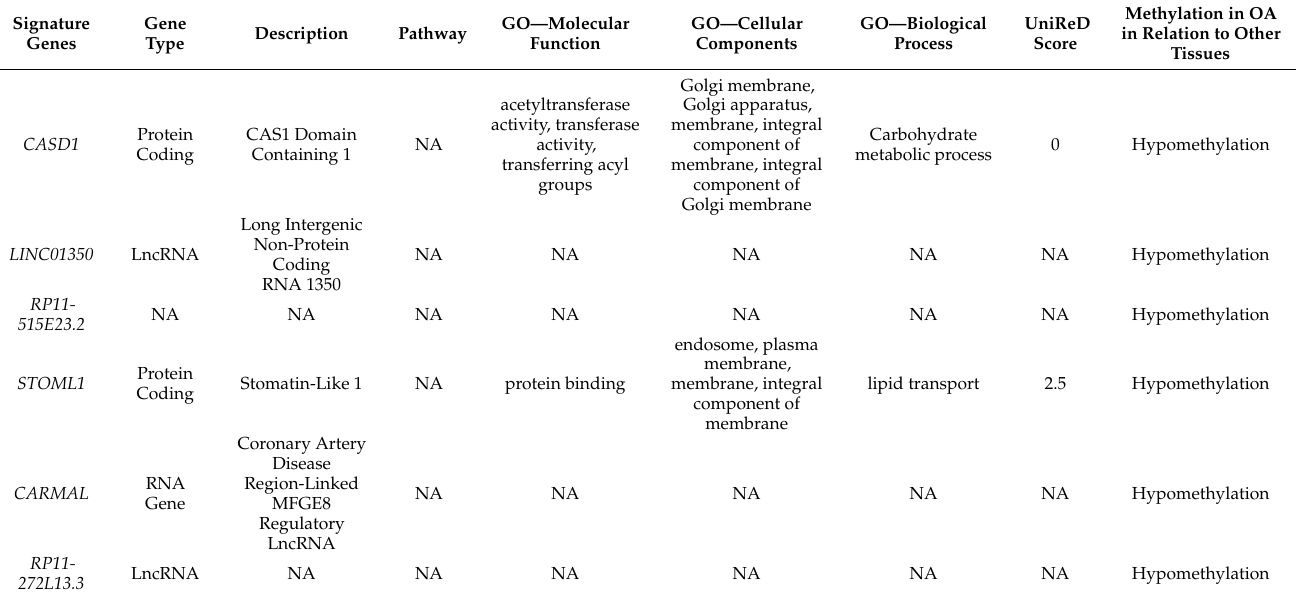
Table 2. Differentially methylated genes selected in the OA cartilage-specific signature built using AutoML analysis. Their biological characteristics and functions revealed by GO analysis as well as their methylation status are